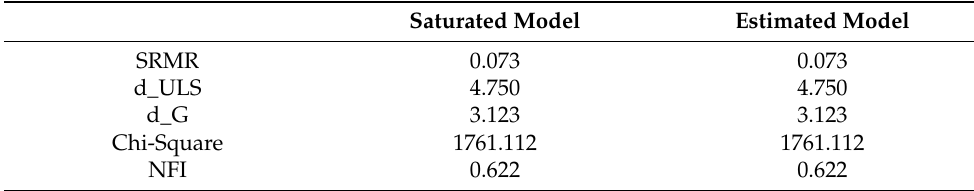
Table 5. Model Fit Indices.